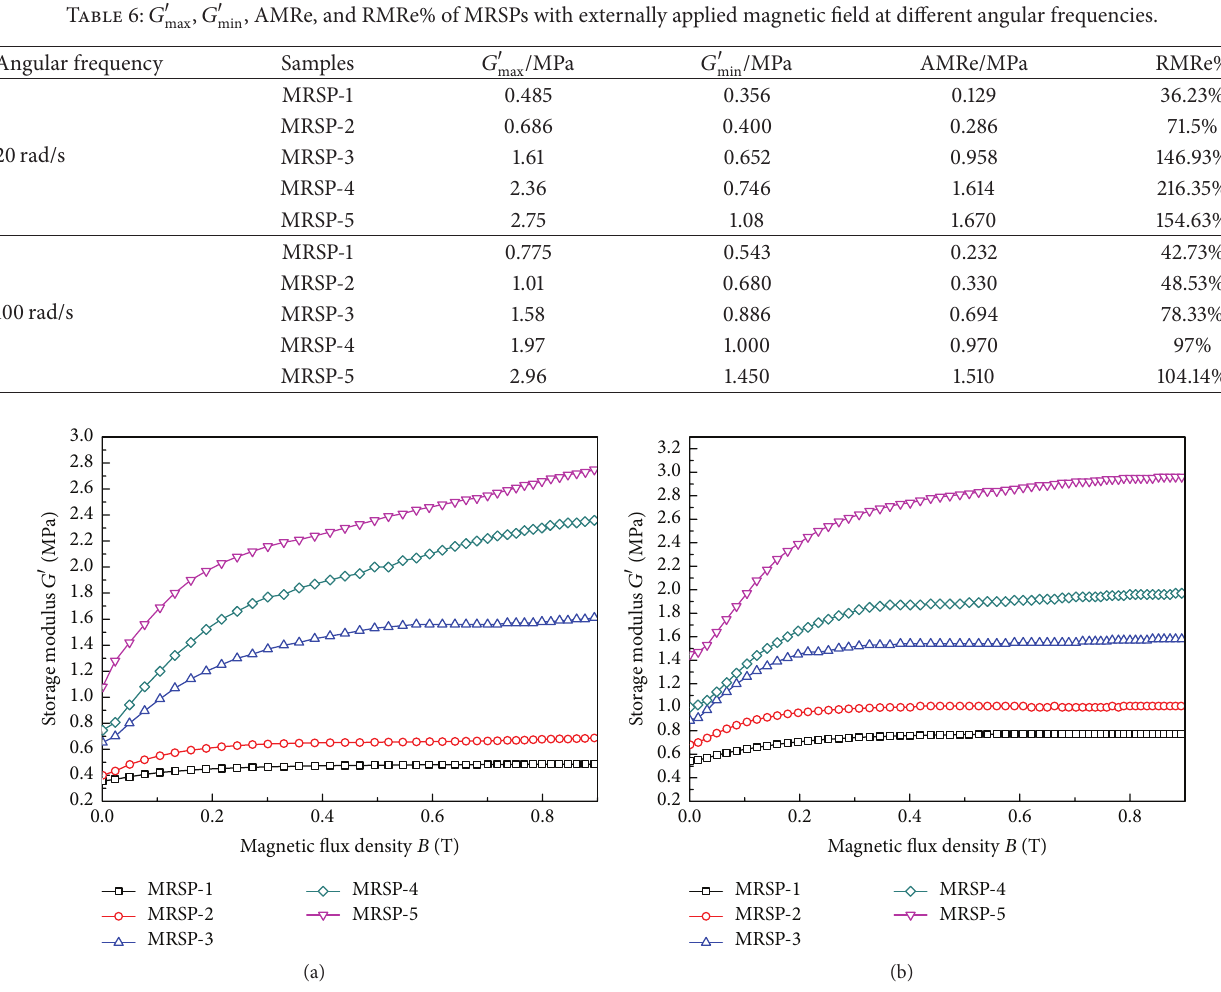
Figure 9: The storage modulus of MRSPs as a function of magnetic flux density at 25 ∘ C (a) angular frequency 20 rad/s and (b) angular frequency 100